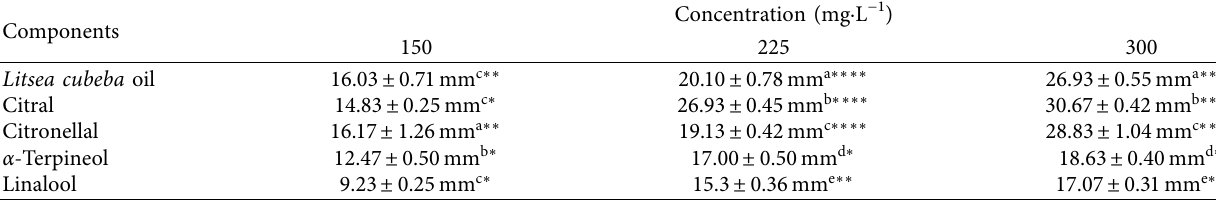
Table 1: The sensitivity of Litsea cubeba oil and its active components.